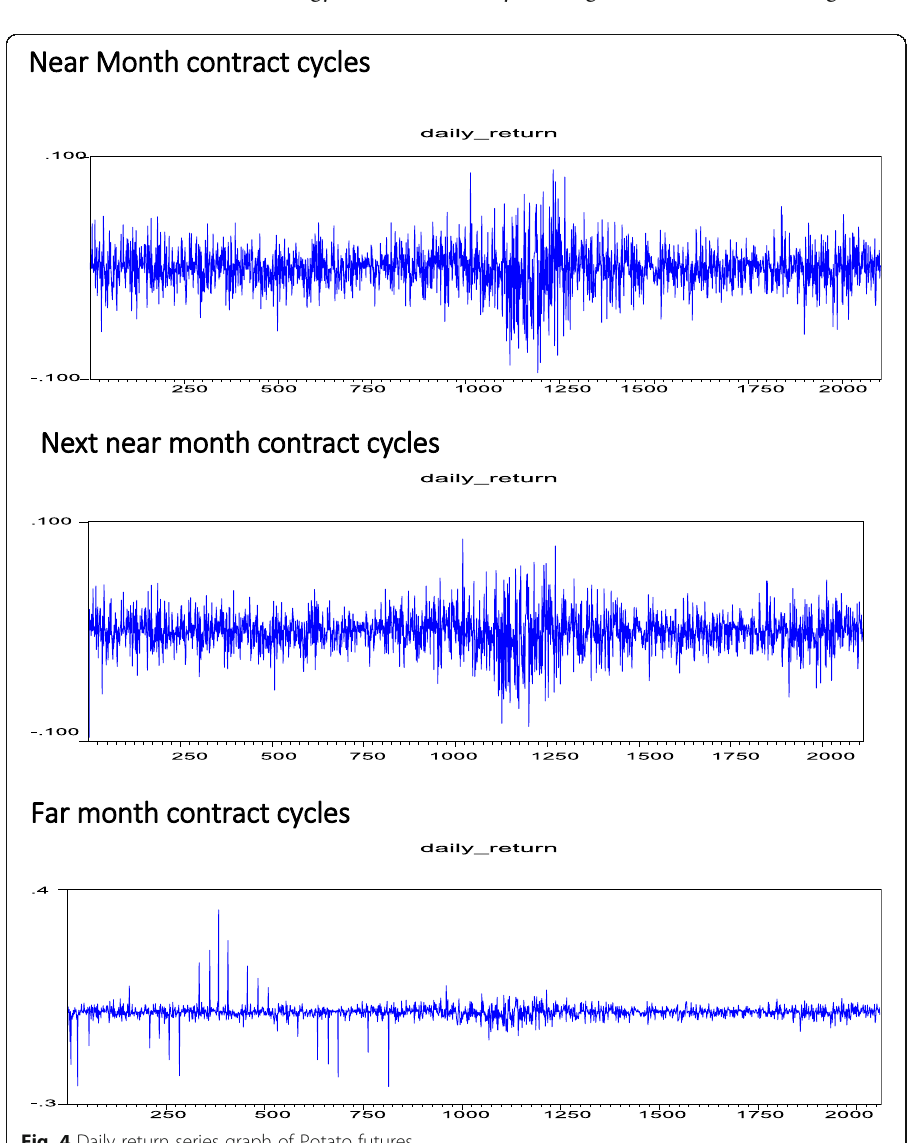
Fig. 4 Daily return series graph of Potato